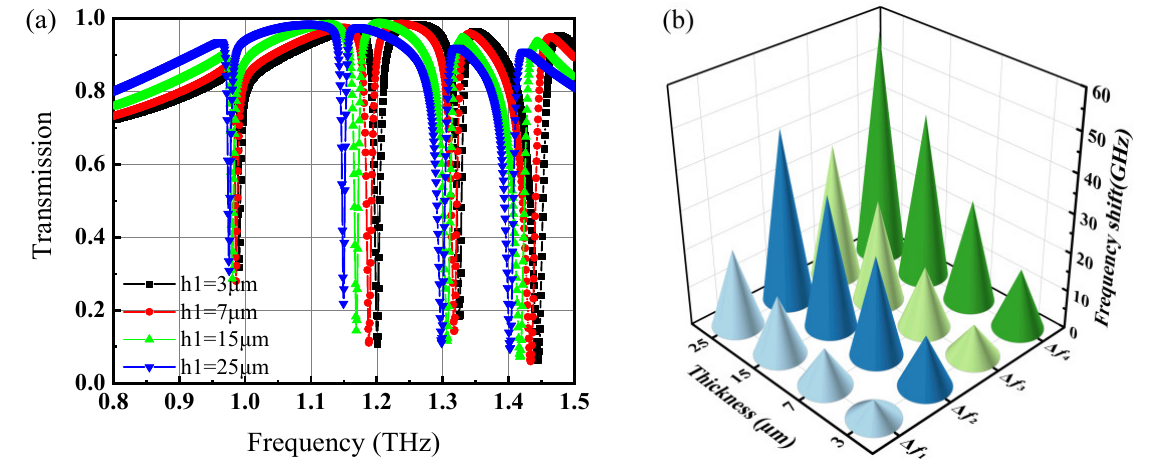
Figure 5. Thickness sensing effect of the sensor: ( a ) transmission spectrum of the sensor surface covered with analytes of different thicknesses, and ( b ) resonance sensing signal frequency versus sample thickness.